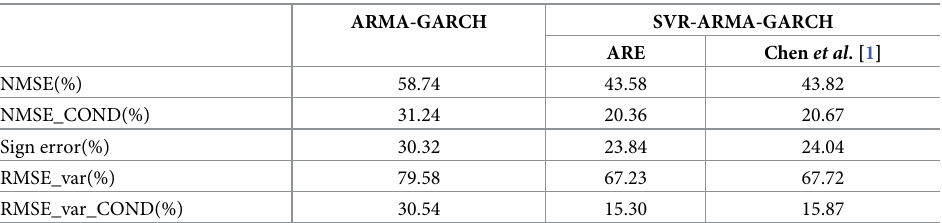
Table 1. Prediction comparison for model based on the Lorenz system.